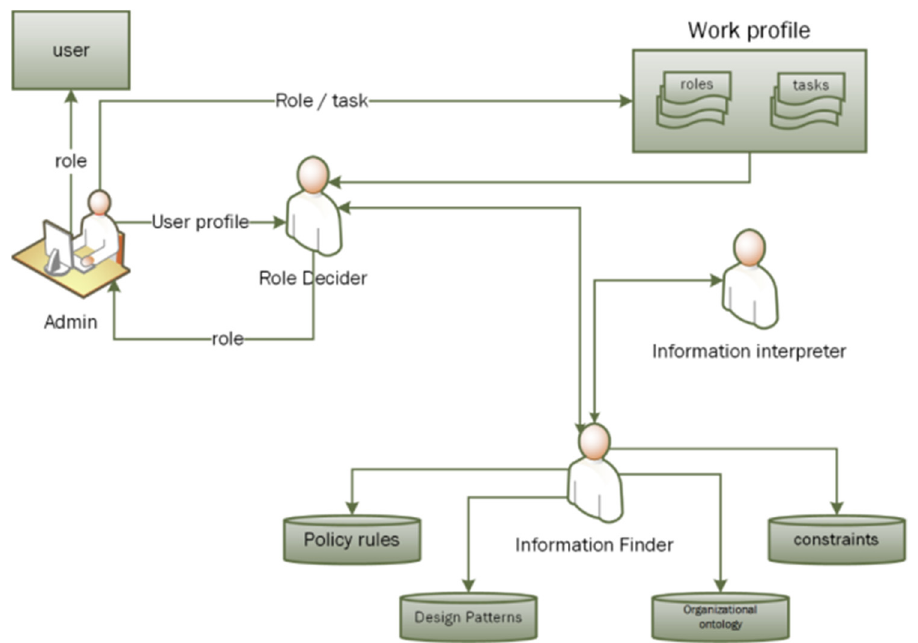
Figure 7. Multi-agent paradigm for role assignment.